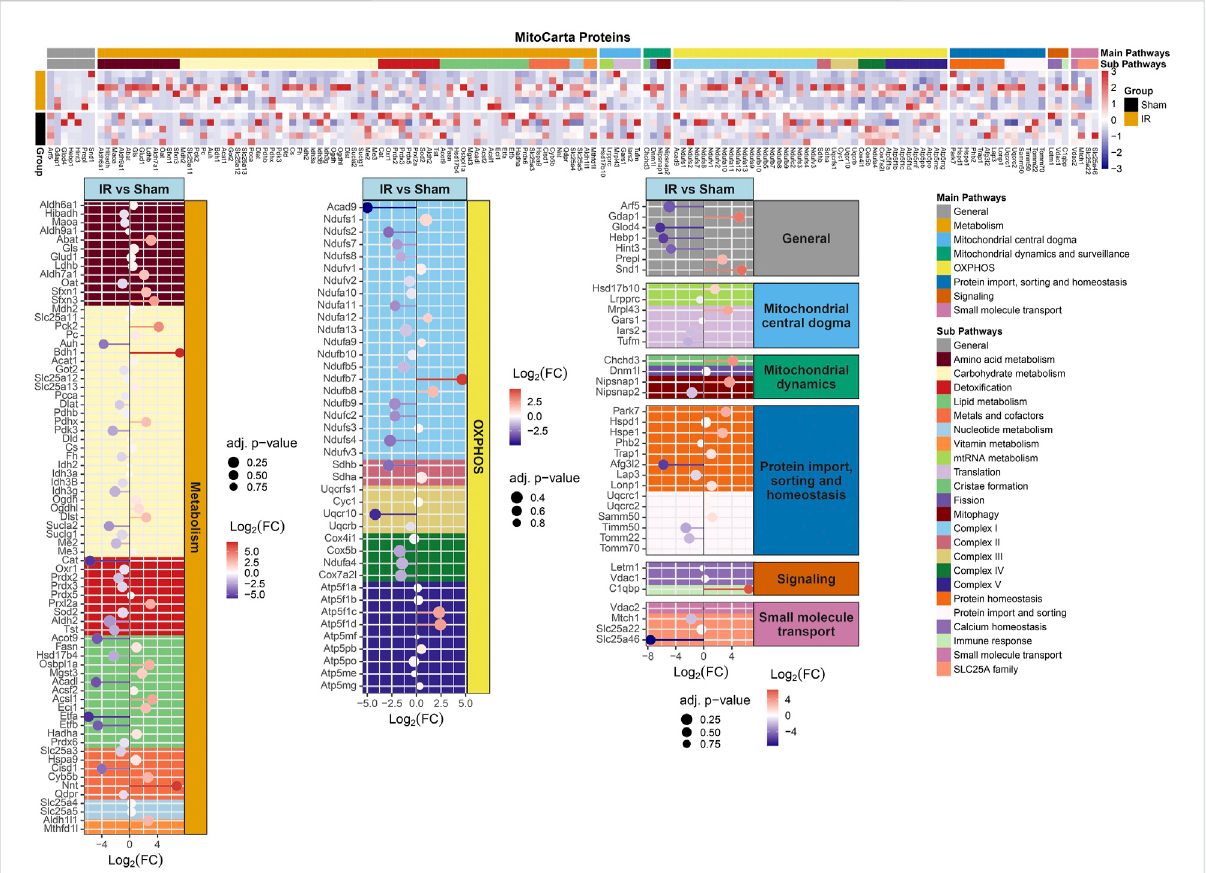
MitoCarta 3.0 genes overlapped with the proteins present for comparing 15 cGy 600 MeV/n 28 Si irradiated rats with sham. Heatmap of the protein expression for the MitoCarta 3.0 genes that are present for individual samples (top plot). The Main Pathway color bar represents the general MitoPathway categories for each protein. The Sub Pathway color bars show the detailed sub-categories for each pathway. Lollipop plots (bottom plots) show the log 2 (Fold-Change) values with the adjusted p -values represented by the size of the symbols for each of the proteins. The side facet represents the main pathway groups, while the background is colored to represent the Sub Pathways. Same color scheme is utilized for the lollipop plots as the heatmaps.